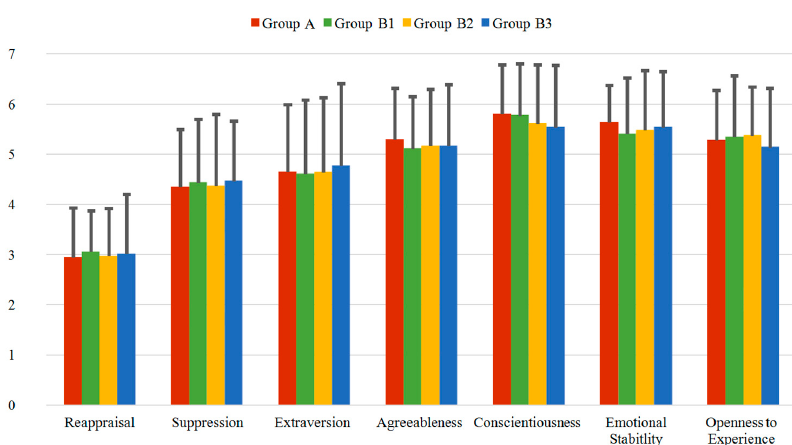
Figure 7. Mean values of the ERQ and TIPI questionnaires for the different groups: Reappraisal and Suppression are the ERQ dimensions, while Extraversion, Agreeableness, Conscientiousness, Emotional Stability, and Openness to Experience are the TIPI dimensions.